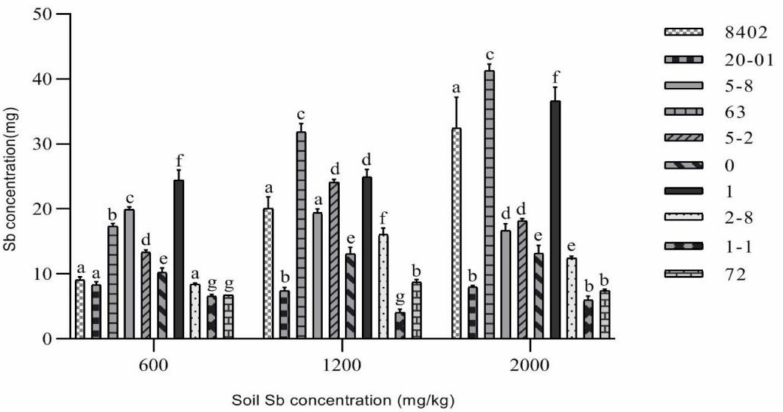
Figure 11. Root Sb accumulation in 10 genotypes. Note: Different letters indicate significant differ- ences in the same treatment at p < 0.05 ( n = 3).